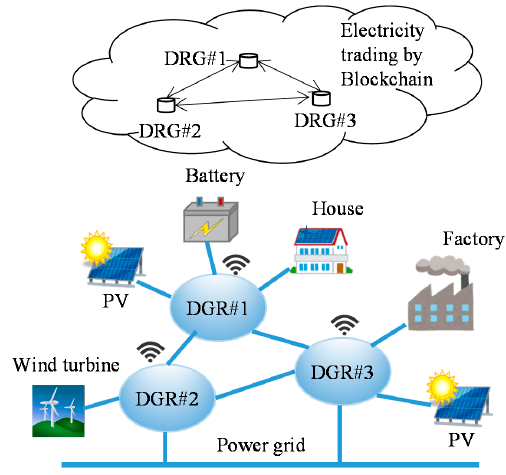
Figure 1. Digital grid system with electricity trading using block-chain.